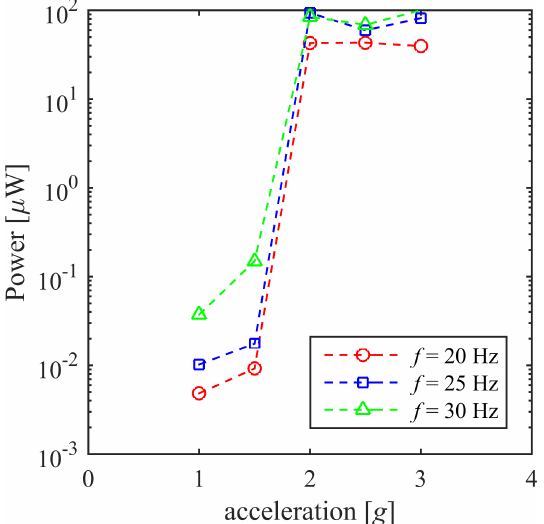
Figure 18. Mean power as a function of the peak amplitude of the sinusoidal excitation at frequencies of 20, 25, and 30 Hz for R L = 400k Ω